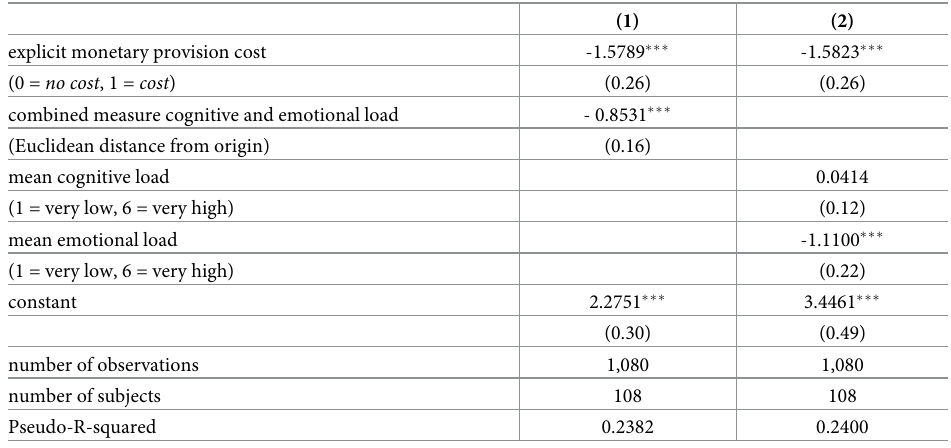
Table 9. Likelihood of item contribution–reduced question set